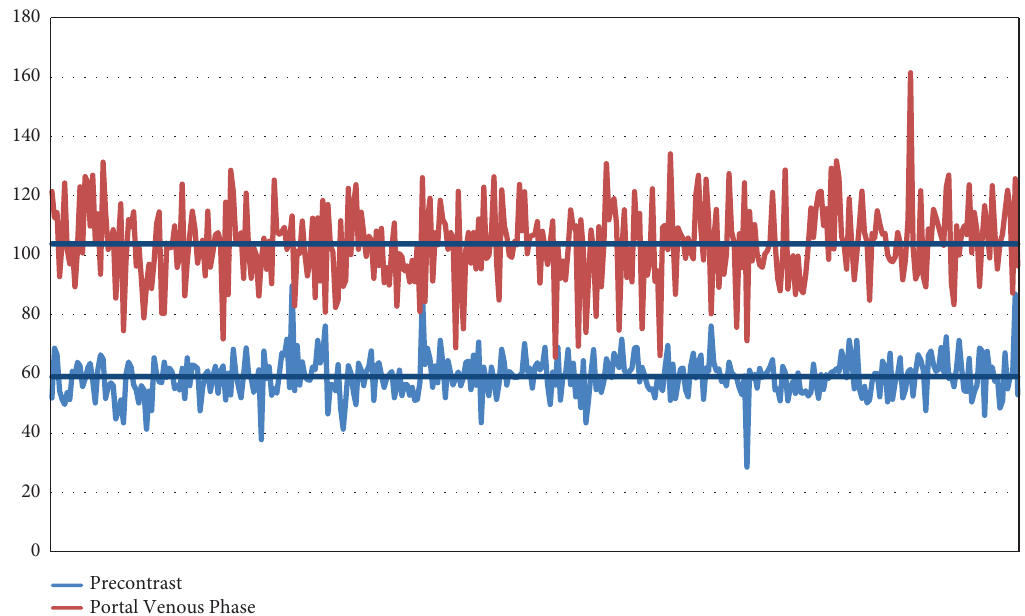
Figure 7: Te precontrast and PVP hepatic attenuation values in abdominopelvic CT performed at TASH, 2022 G.C. Note there is wide variation in the portal venous line compared to the precontrast attenuation line with standard deviations of 12.8 HU and 6.7 HU,